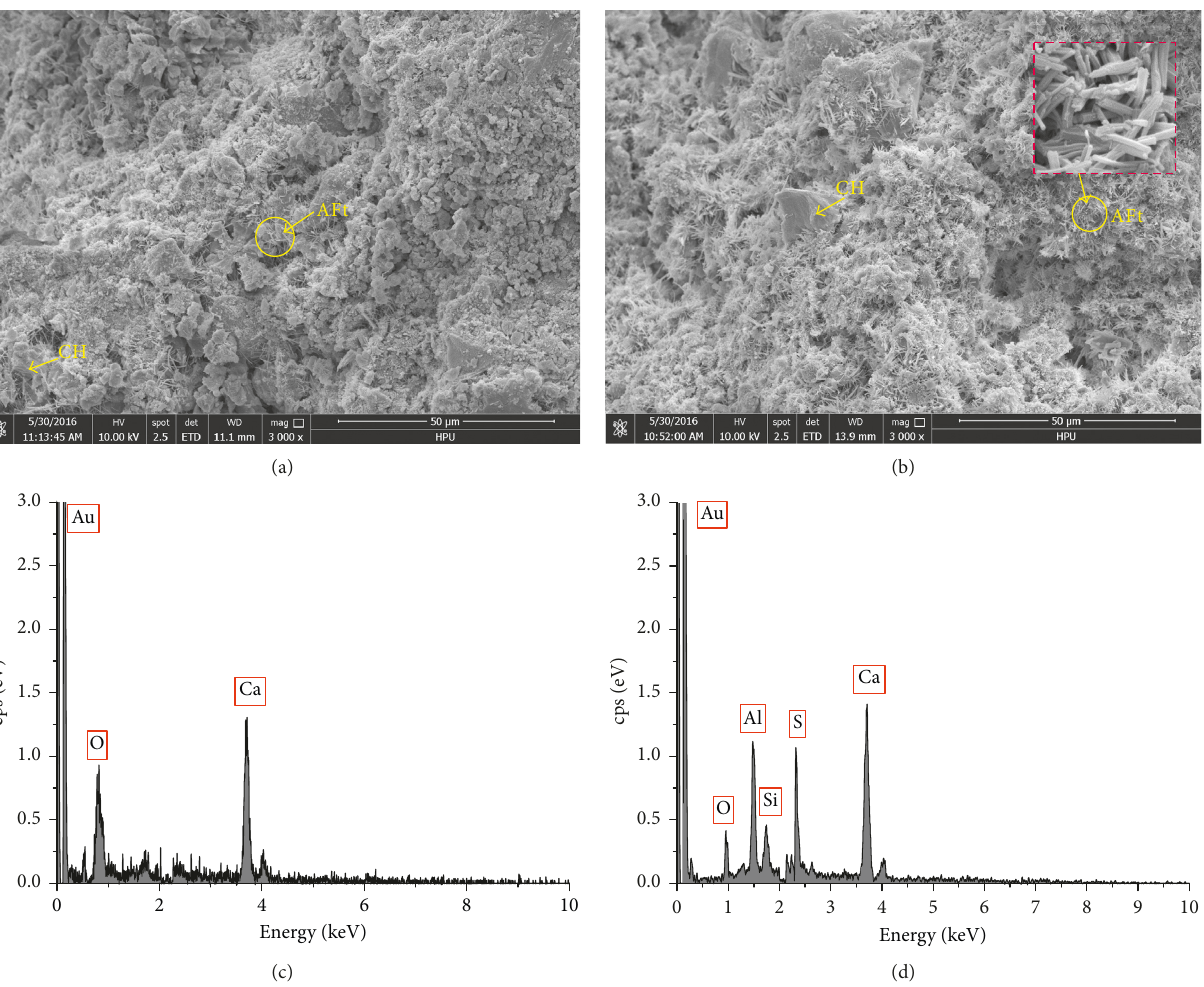
Figure 2: The micrographs of the DE material and the EDS of the CH and Aft crystals: (a) micrograph at the 16th hour; (b) micrograph at the 168th hour; (c) EDS of CH crystal; (d) EDS of AFt crystal.